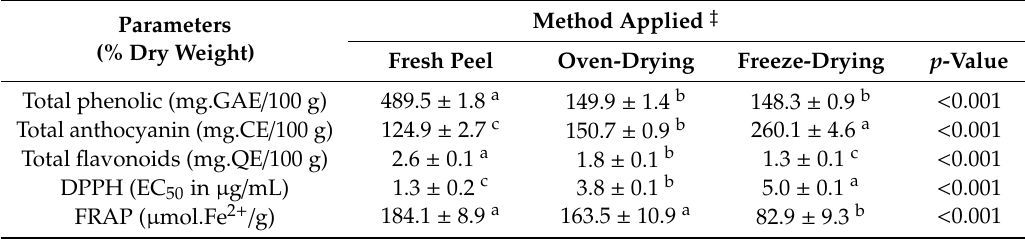
Table 4. E ff ect of the drying method using conventional oven-drying and freeze-dryingprocesses in the total phenolic, total flavonoid, total anthocyanin, and antioxidant activity of the BRS magna grape skin residue. Method Applied ‡ Parameters (% Dry Weight) Fresh